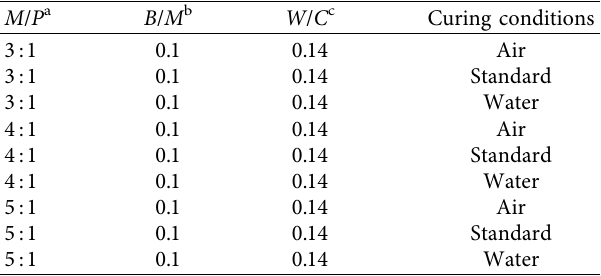
Table 2: Mix proportions of MPC and curing